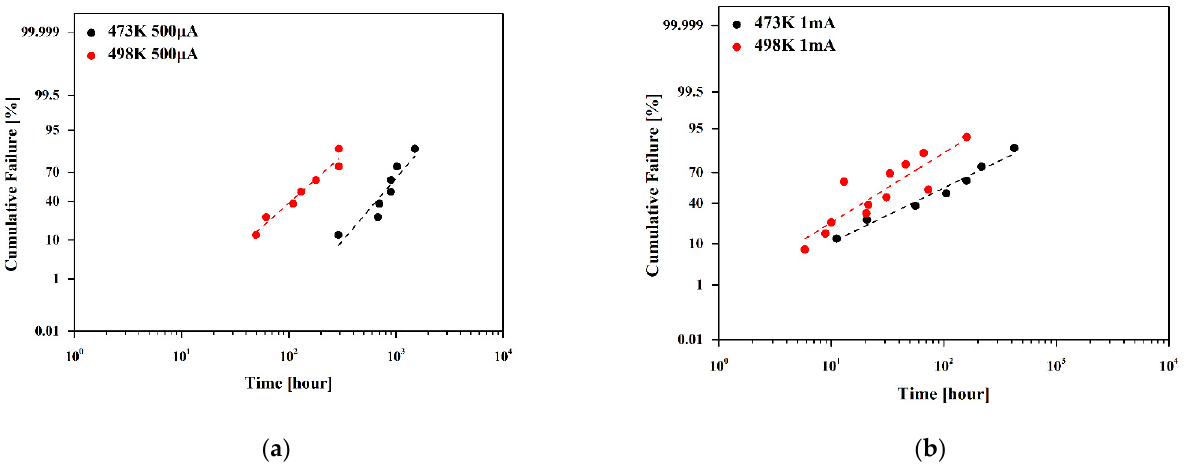
Figure 11. Lognormal projection of the mean time-to-failure versus the percent of cumulative failures for a 10 Gbps planar InGaAs/InP APD after the ALT experiment at ( a ) 500 μ A and ( b ) 1000 μ A.